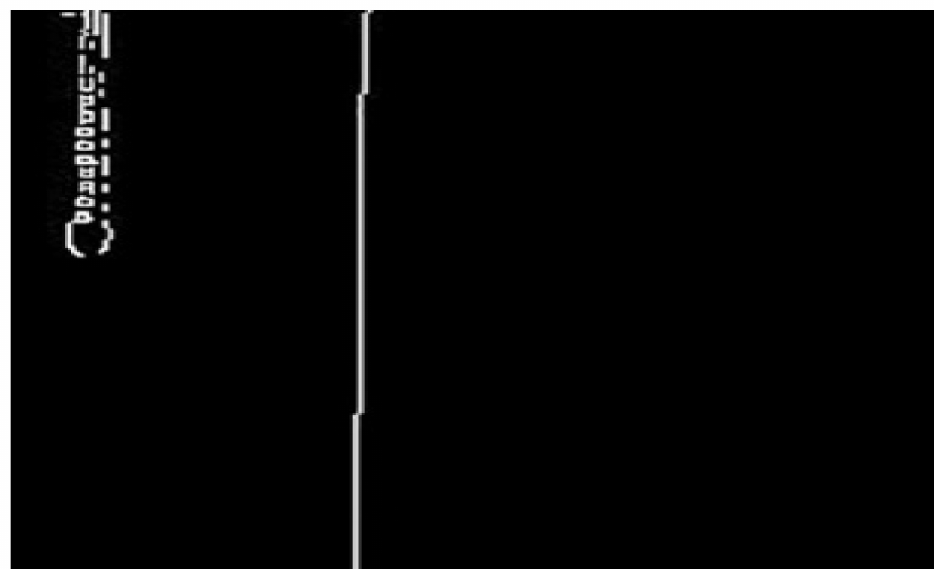
Figure 4. Strip steel defect acquisition region processed by the Canny edge detection